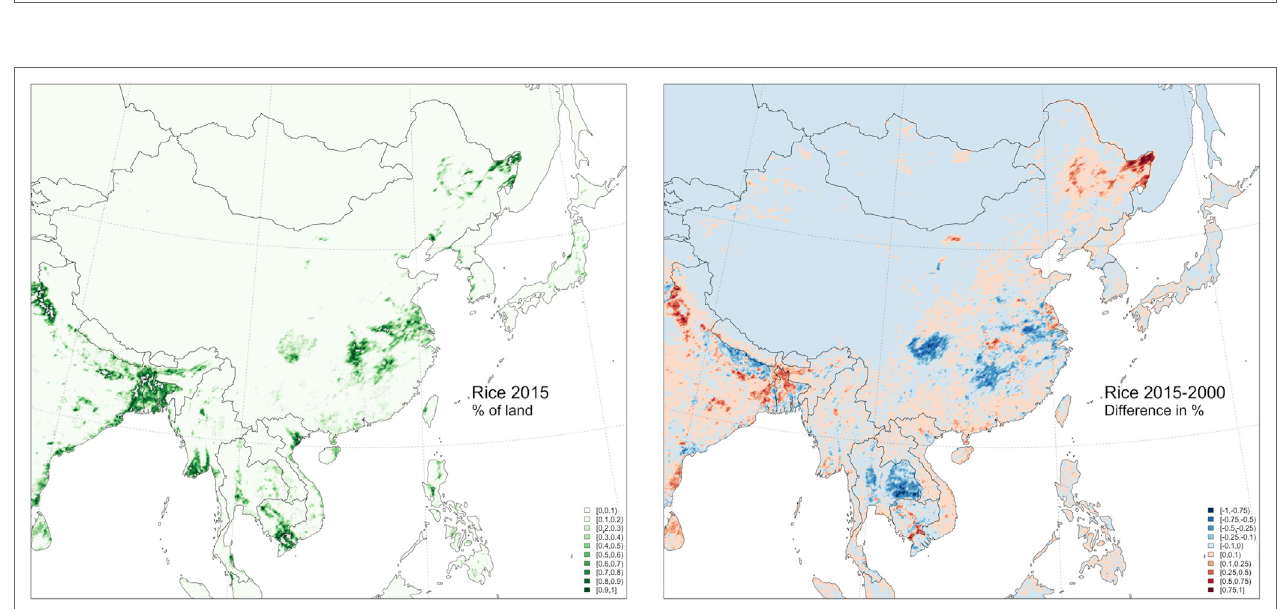
Figure 3 | Distribution of suitability for infection by HPAI H5Nx viruses from Dhingra et al. (20) spatial model (a) and spatial overlay with all Anatidae migration tracks (B)